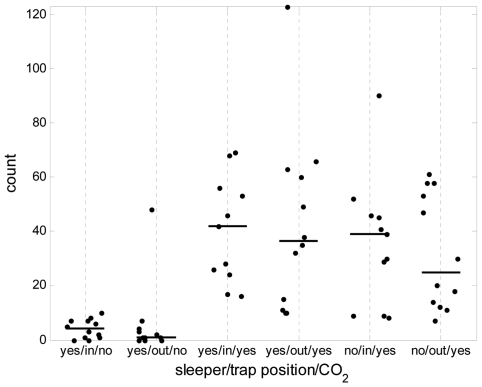
Malaria vector data from Experiment 1.Numbers of female An. gambiae s.l. mosquitoes collected in human odour-baited MM-X traps (count per trap) in an experiment investigating the presence or absence of a sleeper in the hut (yes or no), effect of trap position (indoor or outdoor), use of CO2 in the trap (yes or no). The x-axis shows each treatment group as a combination of these variables. Horizontal bars show the median count per trap for each treatment group.